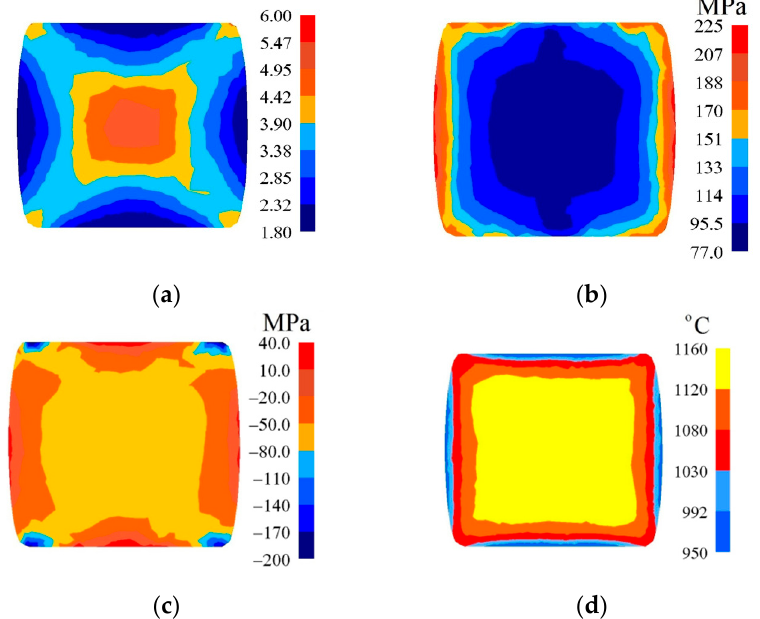
Figure 14. Distribution of the effective strain ( a ), effective stress ( b ), mean stresses ( c ), and temperature ( d ) after the eighth pass of the forging with a concave cross-section in flat anvils ( α c = 150°, ε c = 0.356, forging ratio